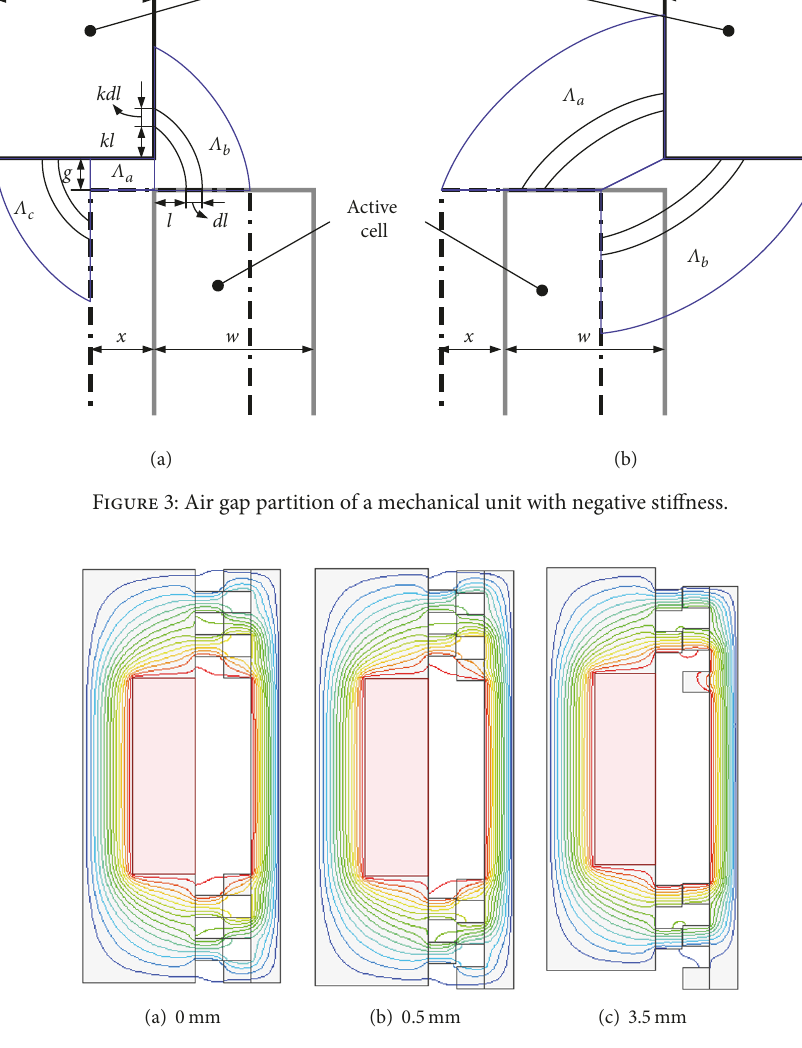
Figure 4: Magnetic fields of EATS for different active cell positions for 𝐼 = 0.6